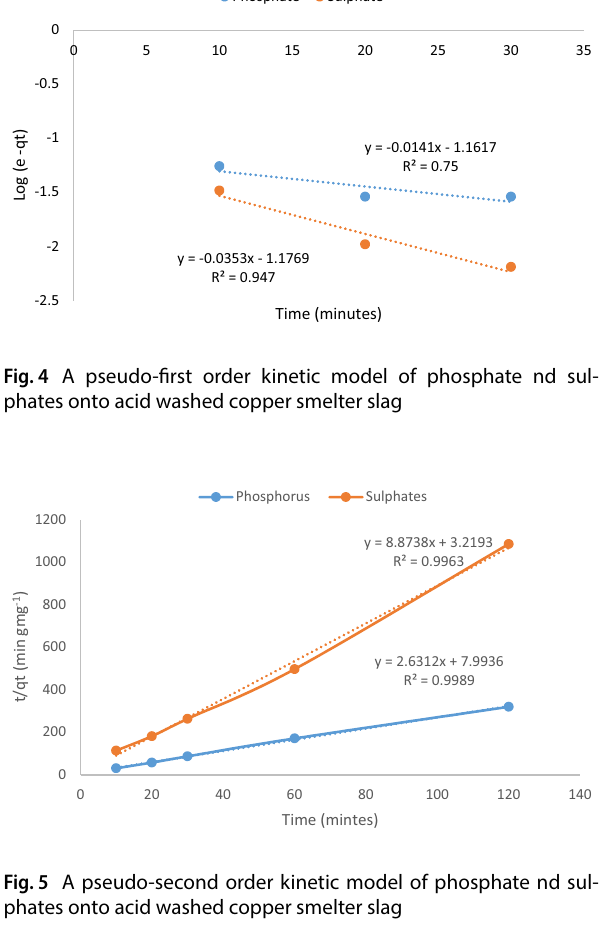
Table 6 Kinetic rate constants relating to adsorption of PO 43− P and SO 42− onto treated copper. smelter slag